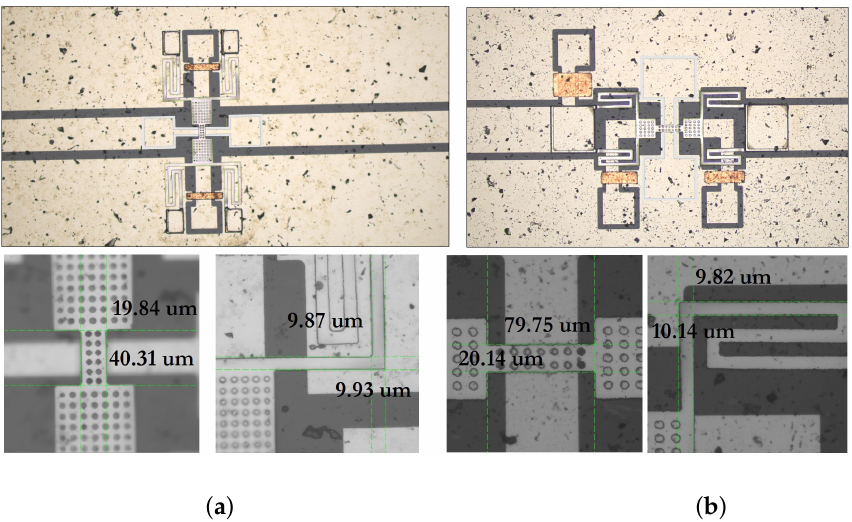
Figure 24. Photos of the manufacturing process of experimental samples: ( a ) RF MEMS switch (A); ( b ) RF MEMS switch